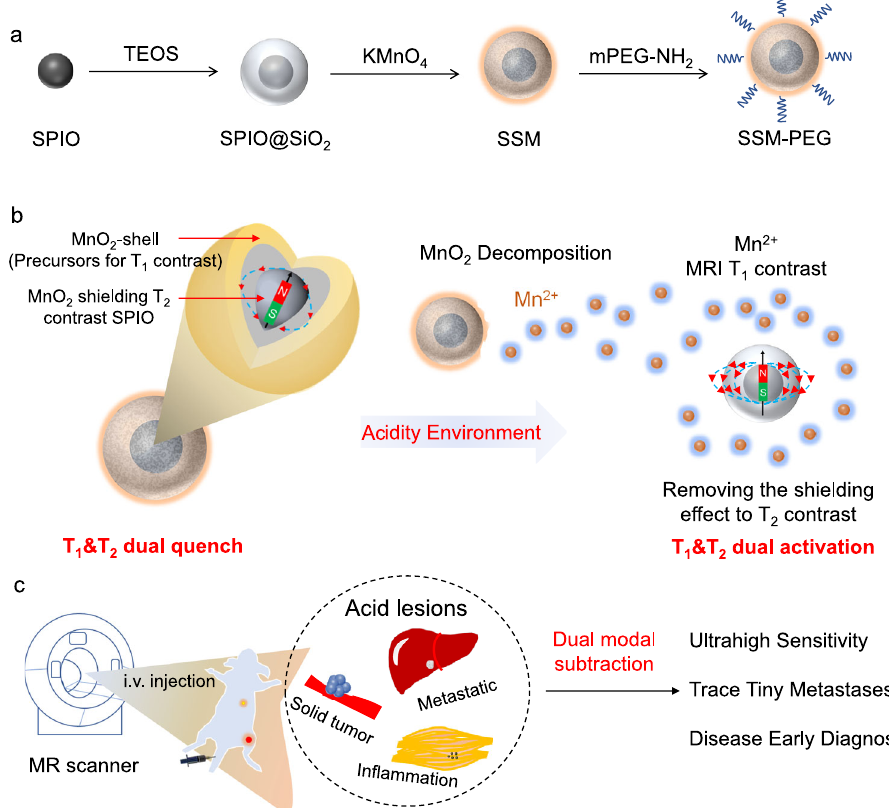
Fig. 1 | Schematic illustration of the structure, working mechanism, and applications of the pH-responsive T 1 and T 2 dual-modal contrast agent. a The synthesis and structure of the contrast agent SPIO@SiO 2 @MnO 2 (SSM). SPIO represents superparamagnetic iron oxide and TEOS represents tetraethyl orthosi- licate; b SPIO@SiO 2 @MnO 2 shows weak T 1 and T 2 contrast intensity in normal